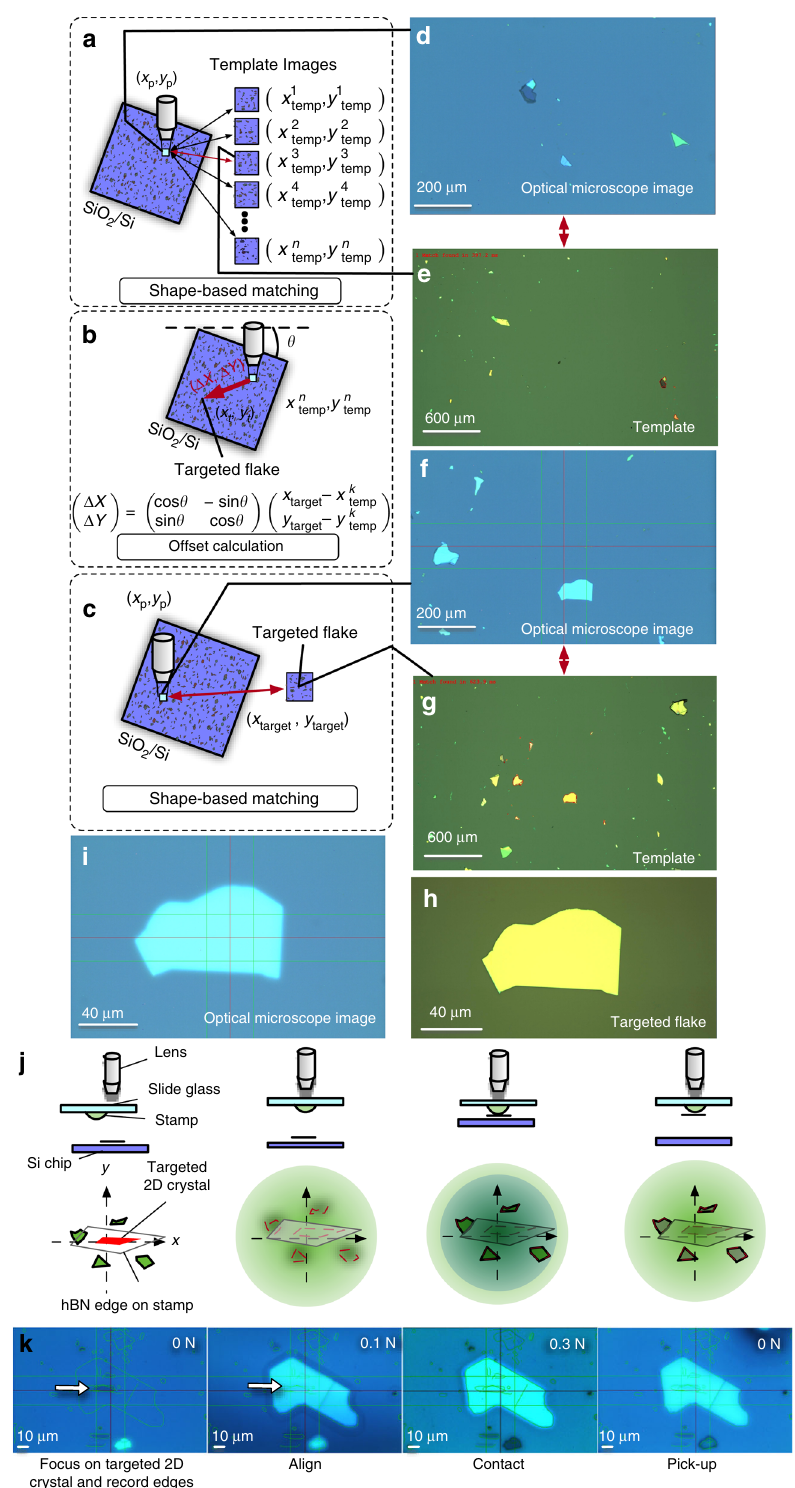
Fig. 7 Alignment procedure. a Schematic of the matching process conducted to extract the current position of the optical microscope ( x p , y p ) from the captured image (square fi lled with light blue). b Geometrical relationship between the targeted fl ake ( x target , y target ) and the extracted position of the optical (cid:2) (cid:3) ; y k . c Schematic procedure for aligning the targeted 2D crystal to the optical microscope center. d – e Representative sample of microscope x k temp temp shape-based matching between the optical microscope image ( d ) and the template image ( e ). The matched 2D crystal edges are indicated by red curves in e . f , g Representative sample of shape-based matching between the optical microscope image ( f ) and the template image ( g ). h Optical microscope image after automated alignment and i template image of the targeted 2D crystal. j Schematics of the alignment procedure to lift targeted 2D crystals. k Optical microscope images obtained at each step of